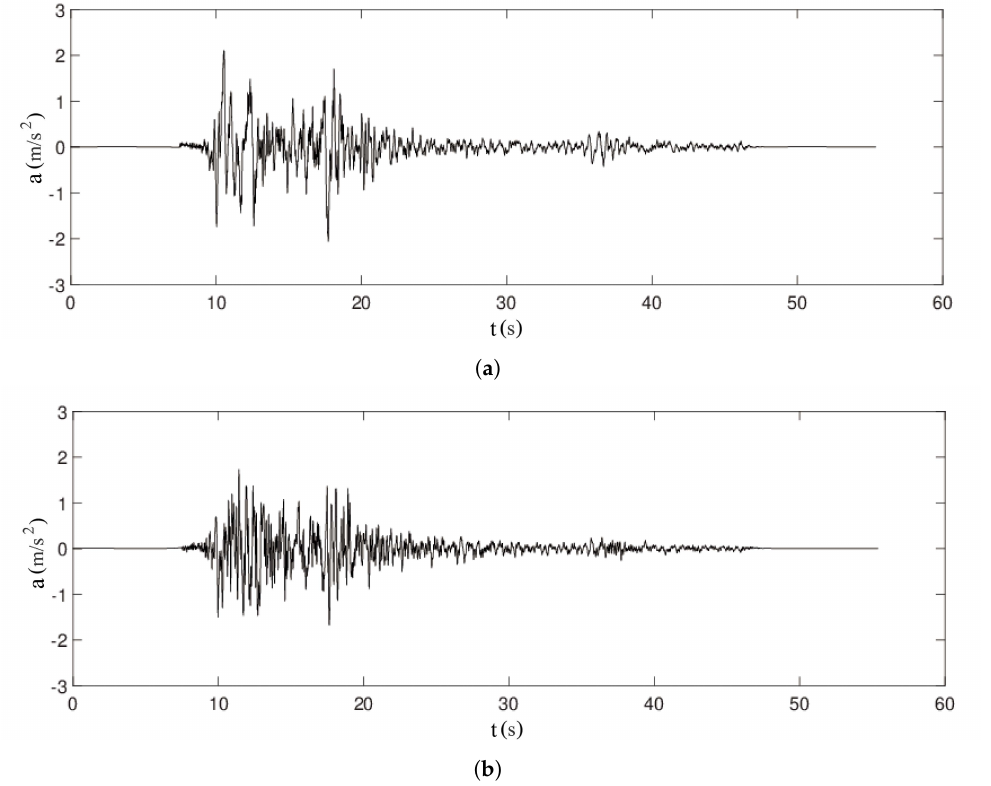
Figure 8. Processed acceleration time-histories of the Montenegro 1979 earthquake at the Albatros station: ( a ) east-west direction. ( b ) north-south direction [80].